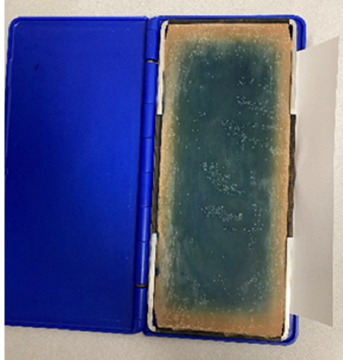
Figure 1. Pedigraph.